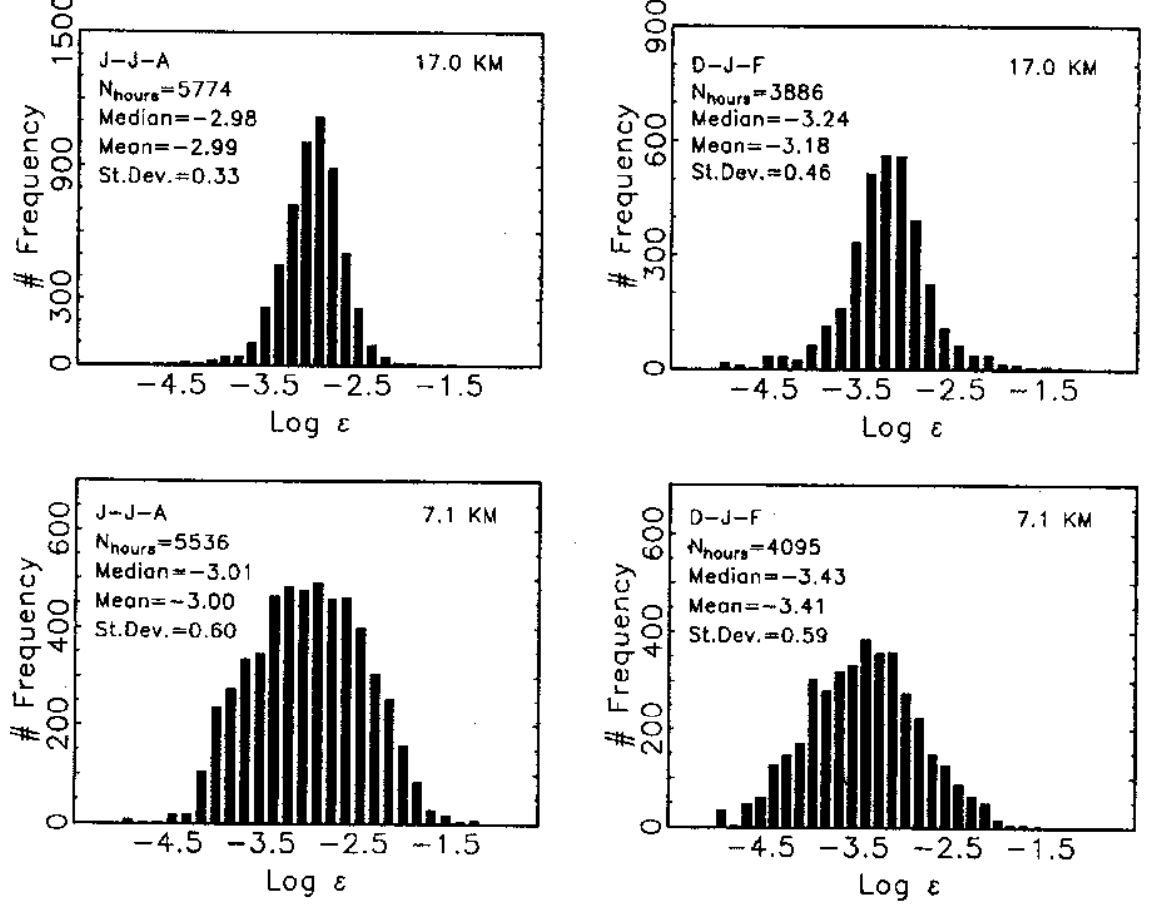
Fig. 8. Frequency distribution of log ((cid:15)) during summer and winter seasons at 7.1 and 17km altitude (Nastrom and Eaton,